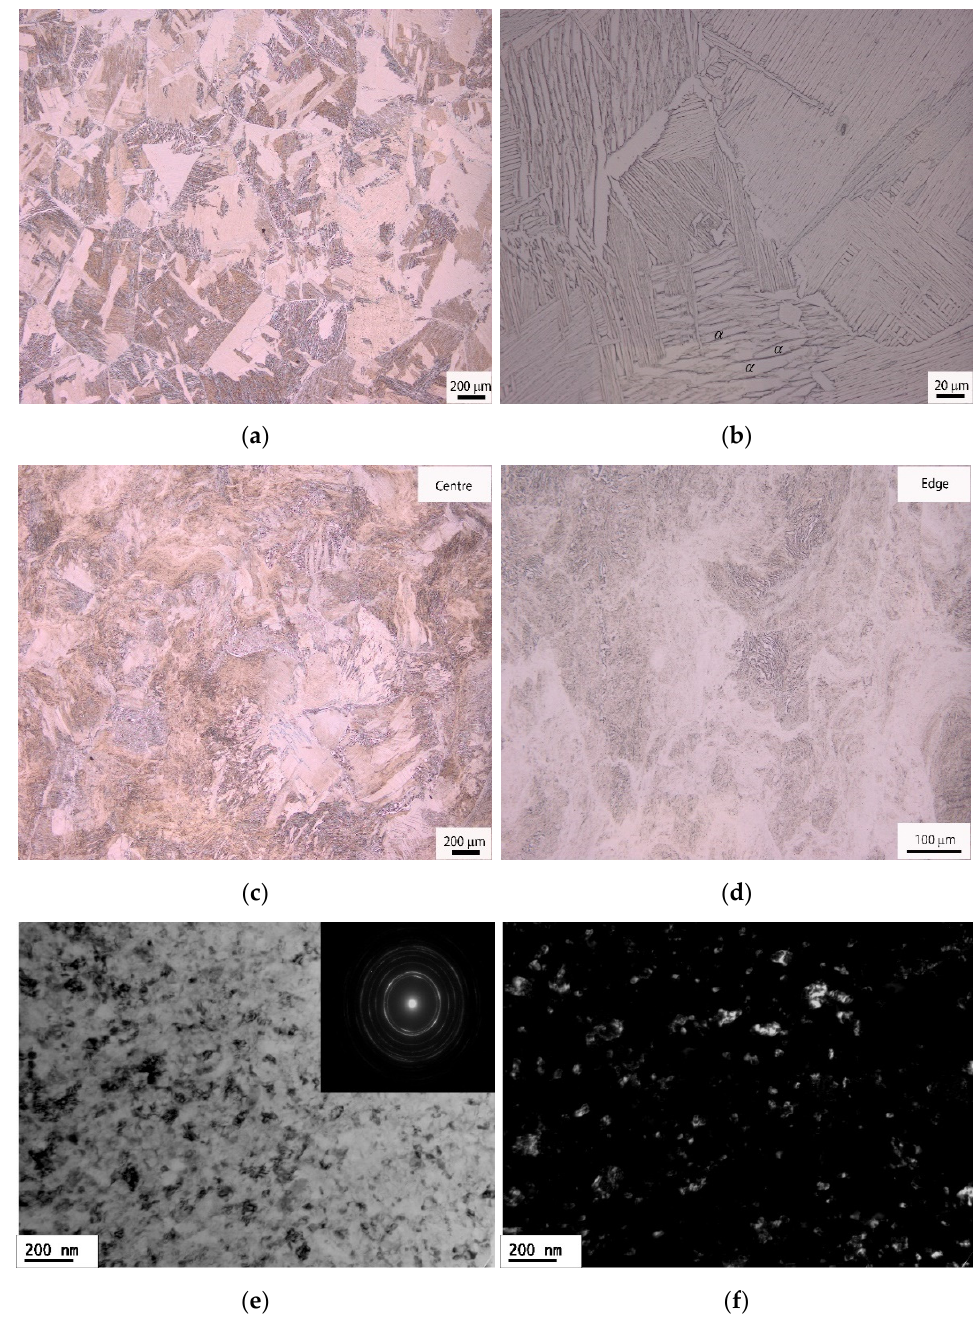
Figure 4. Microstructures of Ti64 in ( a ) as-heat-treated condition with low magnification (OM image, magnification 50 × ), ( b ) as-heat-treated condition with high magnification (OM image, magnifi- cation 500 × ) and after HPT processing ( c ) 1 turn in disc centre area (OM image, magnification 50 × ), ( d ) 1 turn in disc edge area (OM image, magnification 200 × ), ( e , f ) 10 turns at ~4 mm from disc edge area (TEM bright field and dark field